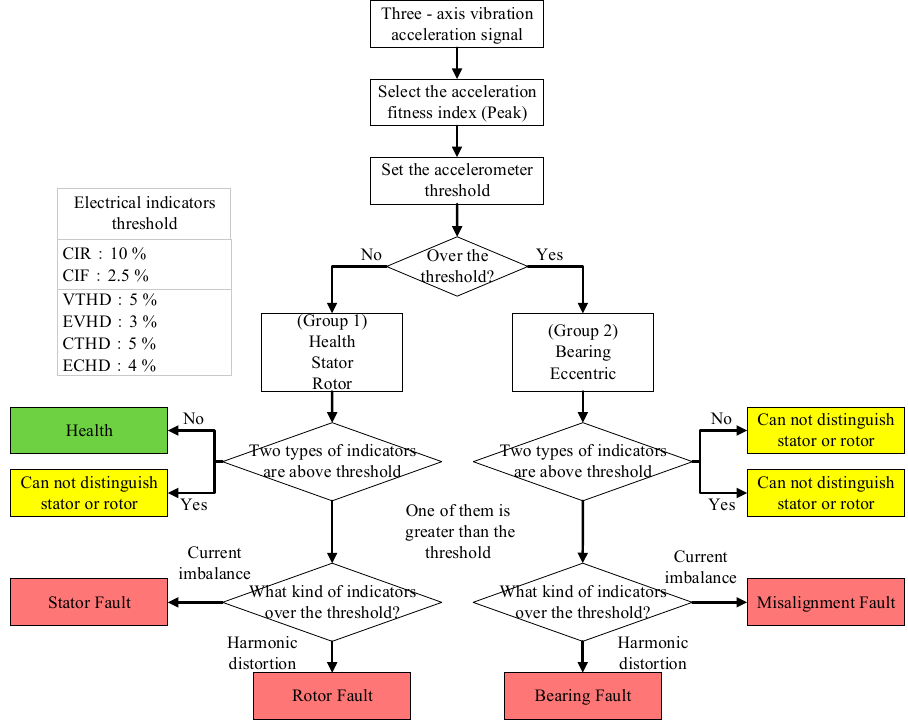
Figure 5. FDA module two-stage hybrid approach flow